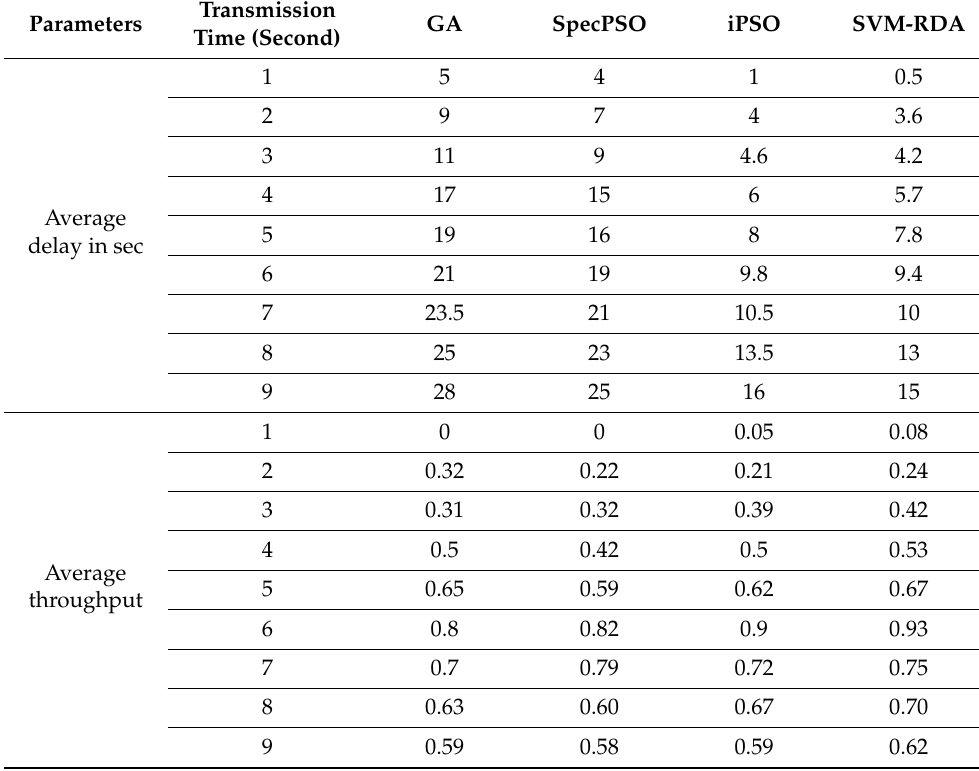
Table 5. Comparison of handoff